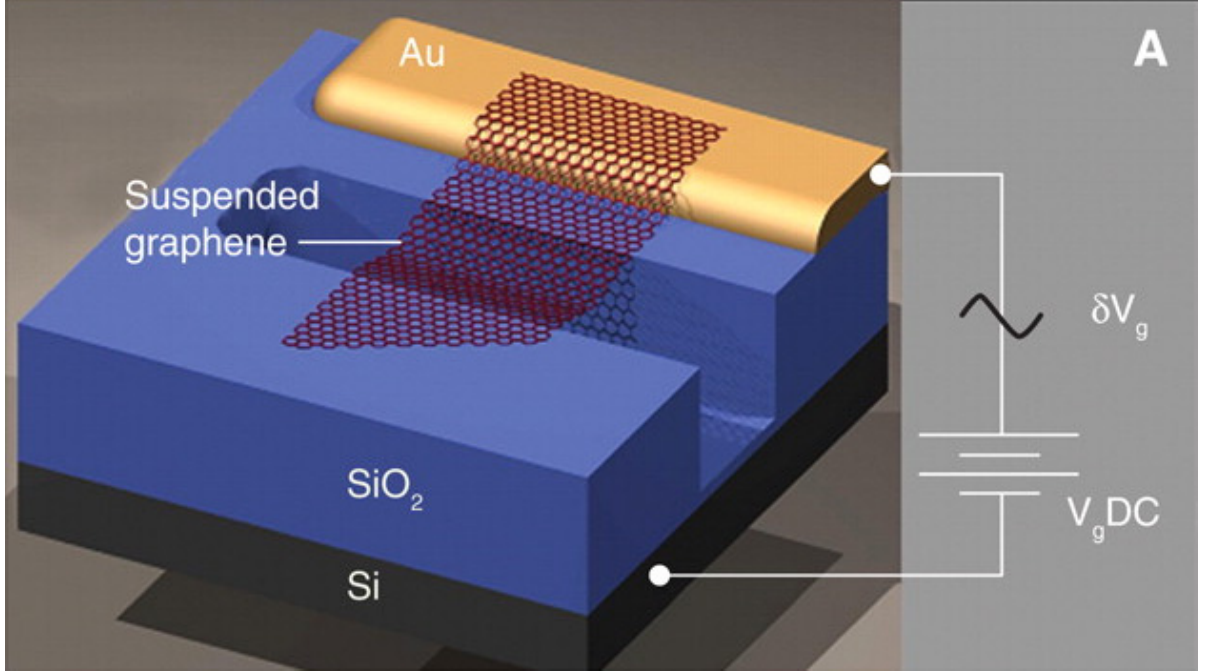
Figure 1. Prototype of a graphene resonator.